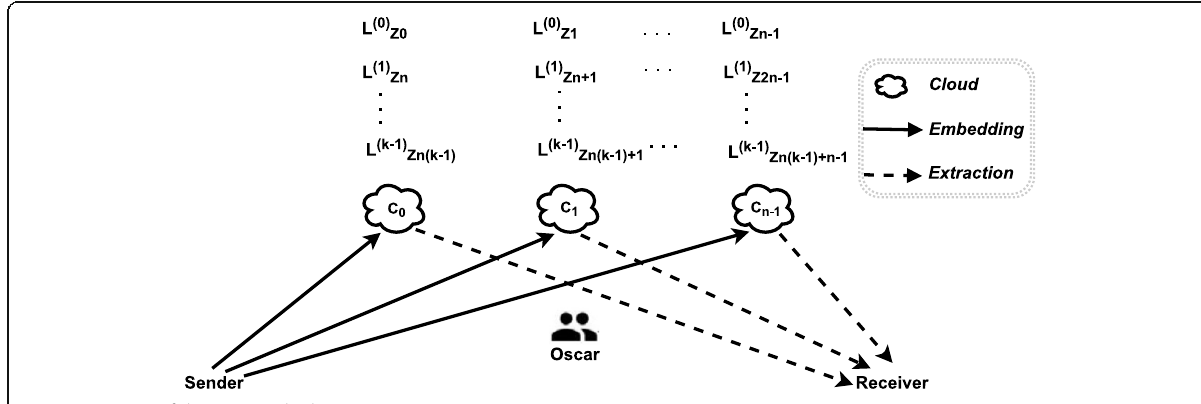
Fig. 3 Overview of the proposed